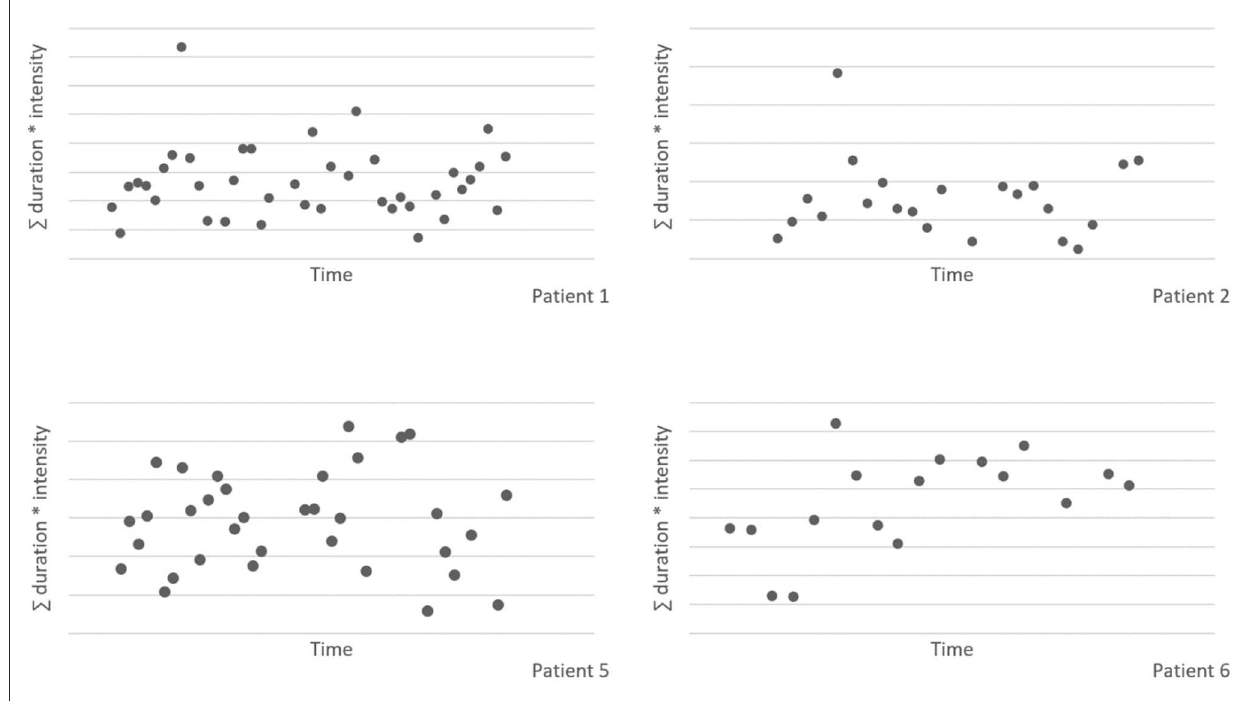
FIGURE3 Nocturnal scratching behavior, measured with the smart watch application.